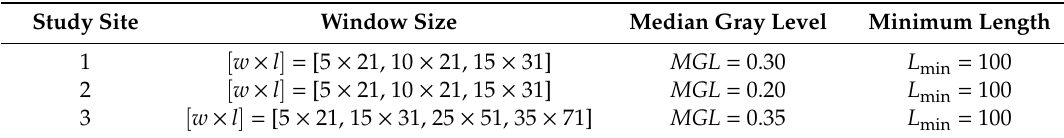
Table 2. Parameters used in the experiments.